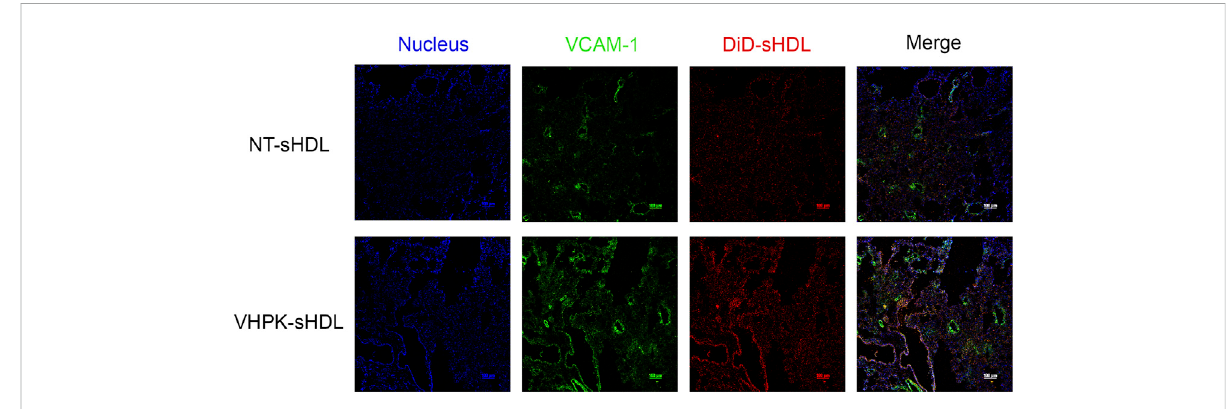
FIGURE 8 Representativeconfocalmicroscopyimagesshowing exvivo bindingofNT-sHDLandVHPK-sHDLonthelungtissuesectionsfromLPS-treated